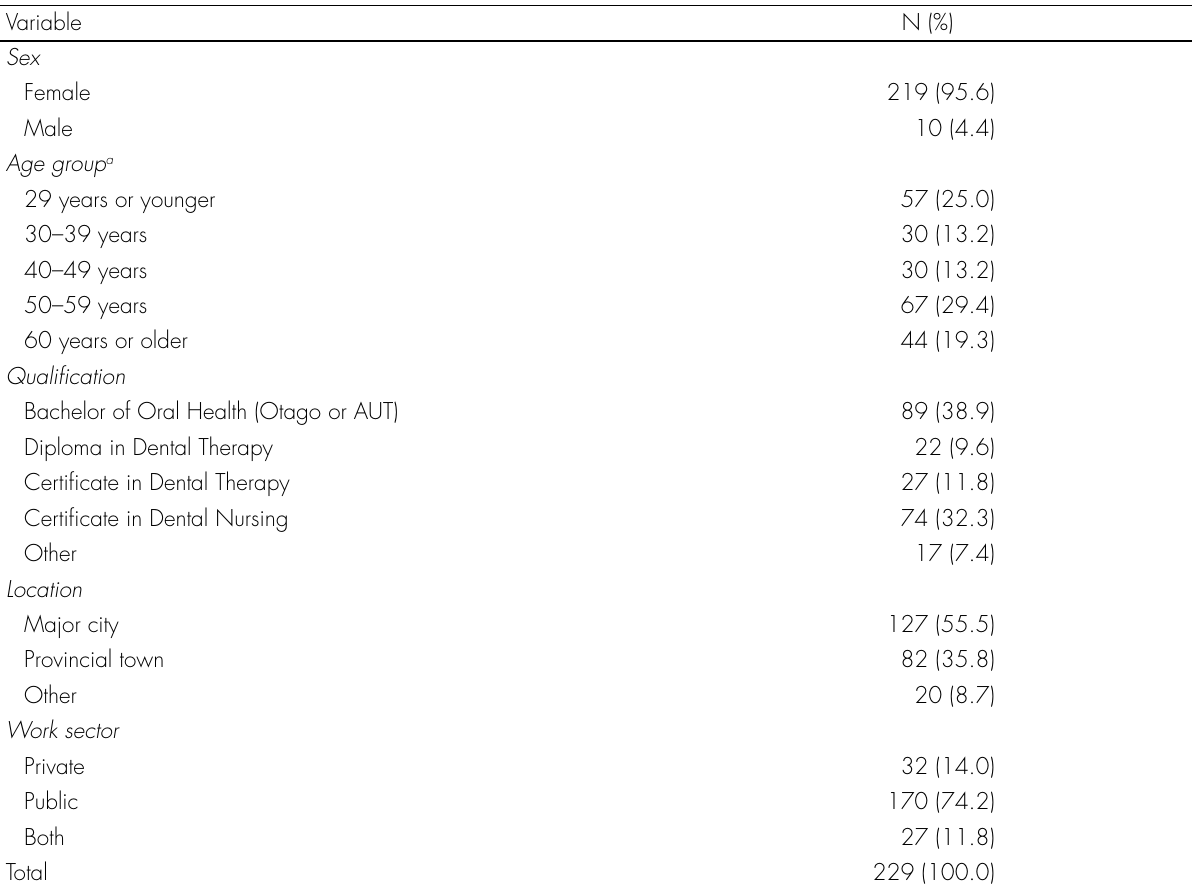
Table II. Socio-demographic and educational characteristics of